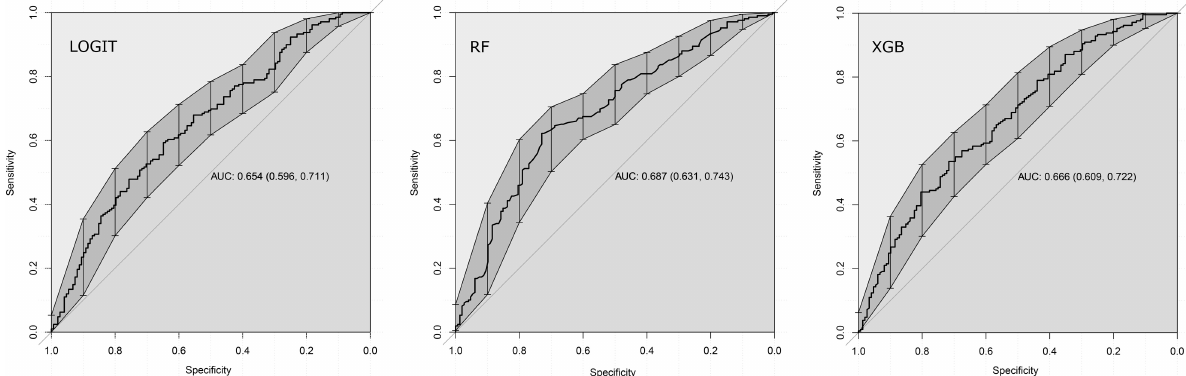
Fig. 3 Individual model performance on the hold-out test set. AUC area under the receiver operating characteristics curve, LOGIT logistic regression, RF random forest, XGB extreme gradient boosted